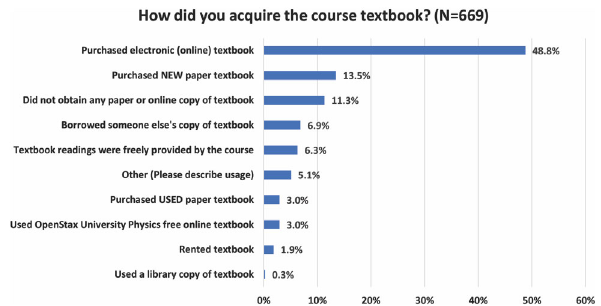
FIG. 2. Students ’ reported textbook usage mode in EAP1, AP1, and AP2 combined.